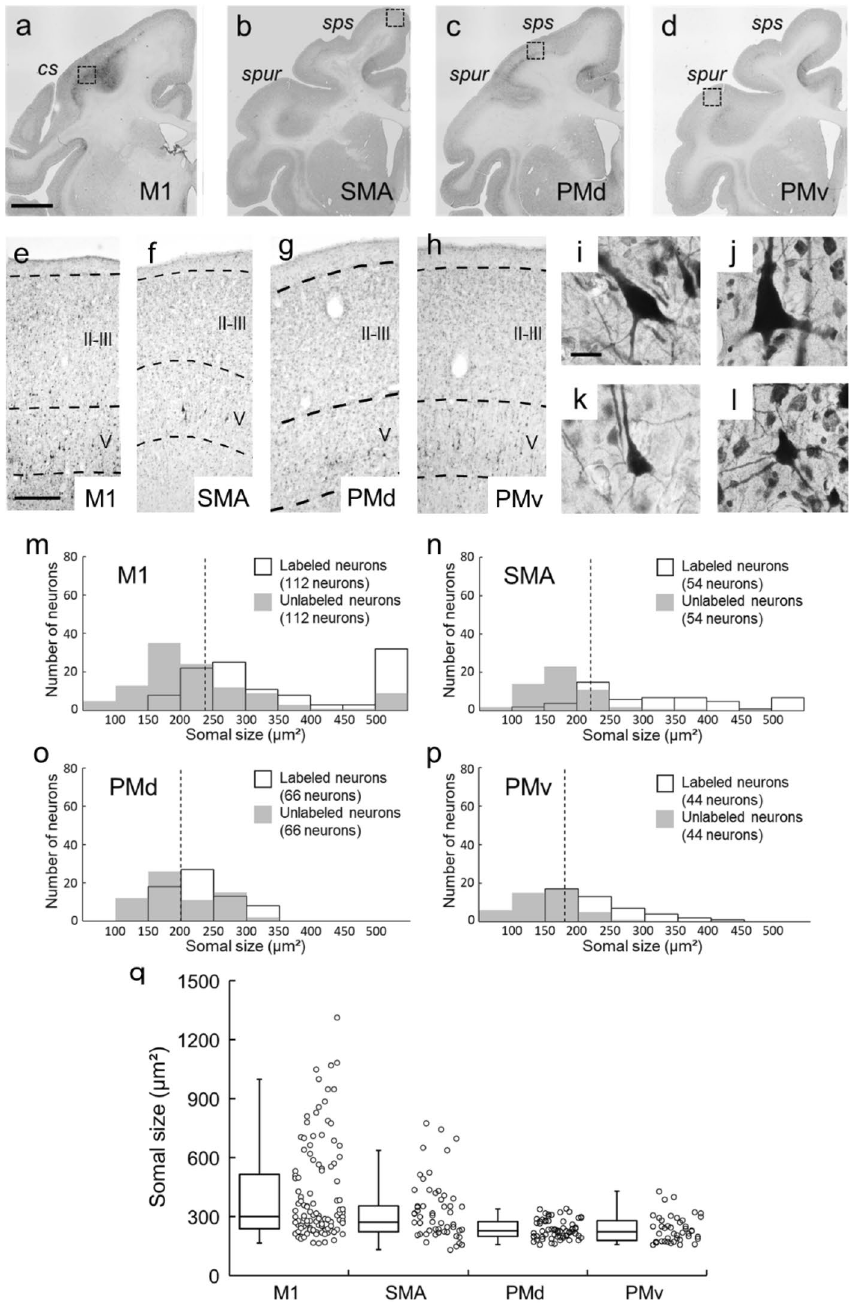
Figure 1. Retrograde labeling of CST neurons in frontal motor-related areas and their somal size measurement. ( a – d ) Low-magnification photos of retrograde labeling of CST neurons in the frontal motor-related areas after rabies injections into the C6–T1 levels of the spinal cord. ( a ) M1, ( b ) SMA, ( c ) PMd, ( d ) PMv. Scale bar, 5 mm. cs, central sulcus; sps, superior precentral sulcus; spur, spur of the arcuate sulcus. ( e – h ) Higher-magnification photos in the M1 ( e ), SMA ( f ), PMd ( g ), and PMv ( h ). Scale bar, 500 µm. II, layer II; III, layer III; V, layer V. ( i – l ) Representative CST neurons (i.e., large layer V pyramidal neurons) taken respectively from dotted squares of panels ( a – d ). Scale bar, 20 µm. ( m – p ) Measurement of the somal size of labeled CST neurons in the motor-related areas. As control, the same number of unlabeled layer V pyramidal neurons was sampled from each area. Data were obtained in 112, 54, 66, and 44 neurons sampled from 14 sections through the M1 ( m ), SMA ( n ), PMd ( o ), and PMv ( p ), respectively. Dotted line indicates the first quartile for the labeled CST neurons in each area. ( q ) Distribution of the somal size of labeled CST neurons in each area (left, box plot; right, dot